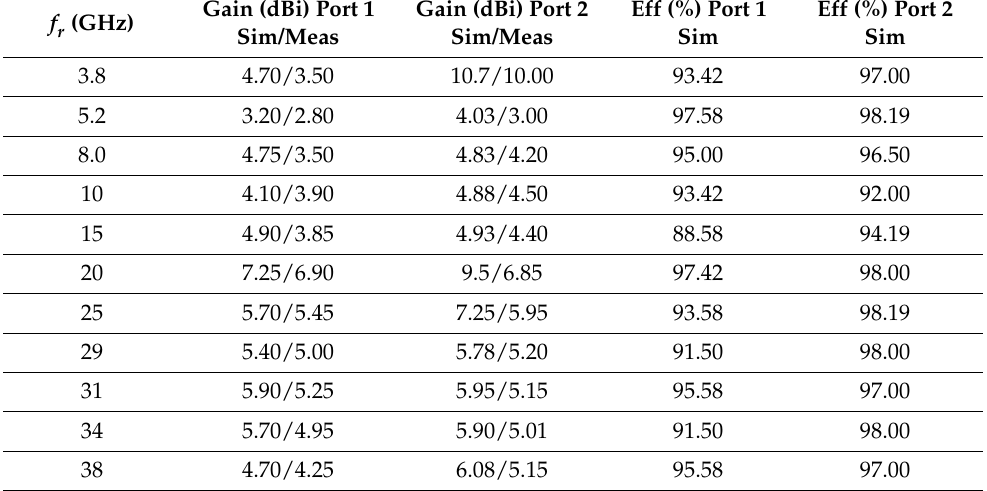
Table 4. The performance of MTM- band MAVA with 8-ports at the resonance frequencies when ports 1 and 2 are active (Sim: Simulation, Meas: Measurement).